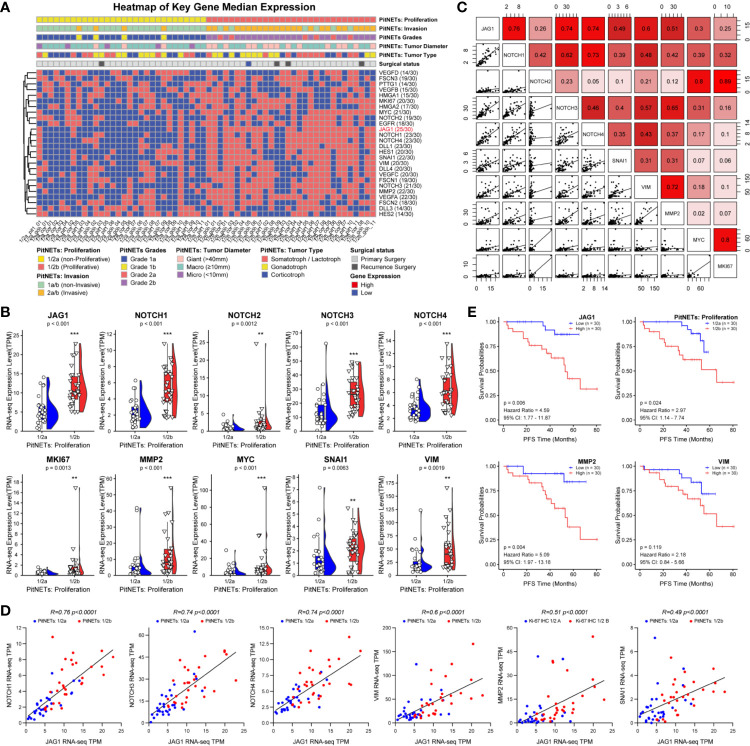
Notch signaling pathway involved into the tumorigenic and recurrence of PA. (A) Heatmap of key gene median expression including angiogenesis, high mobility group family and Notch signaling pathway. Pathological and clinical annotations were provided. (B) RNA-seq quantitative levels (TPM) of Notch pathway and genes related to EMT. (C) The correlation analysis between Notch pathway and EMT. (D) The correlation of between JAG1 and Notch receptors, genes related to EMT. Log2FC<−1 or >1, P<0.01 (E) PFS time according the levels of JAG1, MMP2, SNAI1 and VIM. Log2FC<−1 or >1, P <0.01. **p < 0.01, ***p < 0.001.